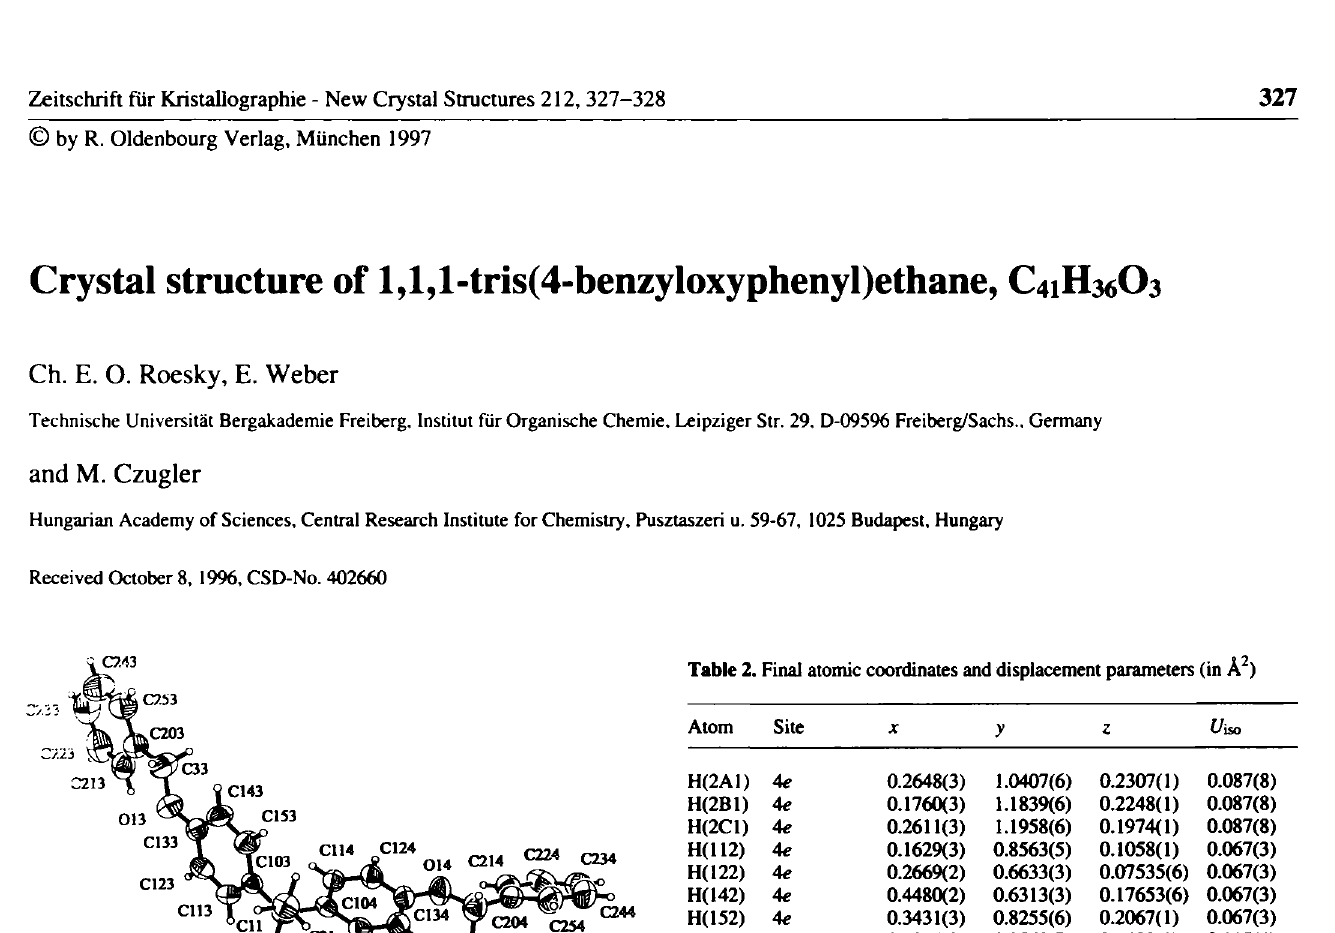
Table 2. Final atomic coordinates and displacement parameters (in A 2 )